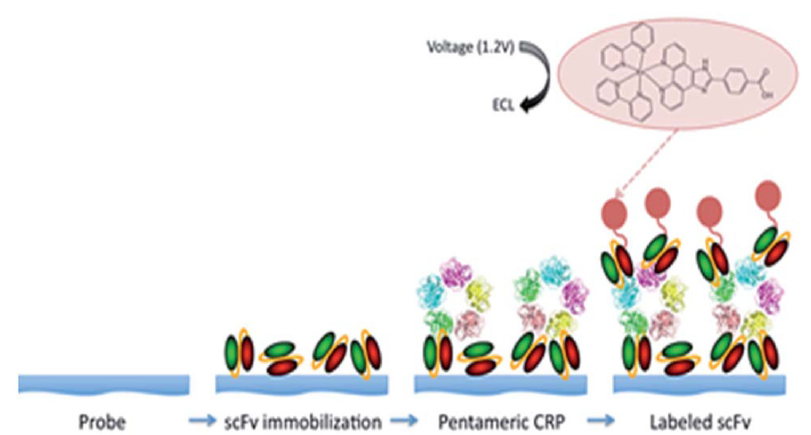
Figure 14. Schematic illustration of the fabrication of recombinant antibody-based biosensor for the detection of C-reactive protein. First, scFv fragments are immobilized on the electrode surface. Second, the pentameric CRP target binds. Third, scFv fragments that are labeled with a ruthenium polypyridine type metal complex are bound and used to generate ECL. Reproduced with permission from [90].